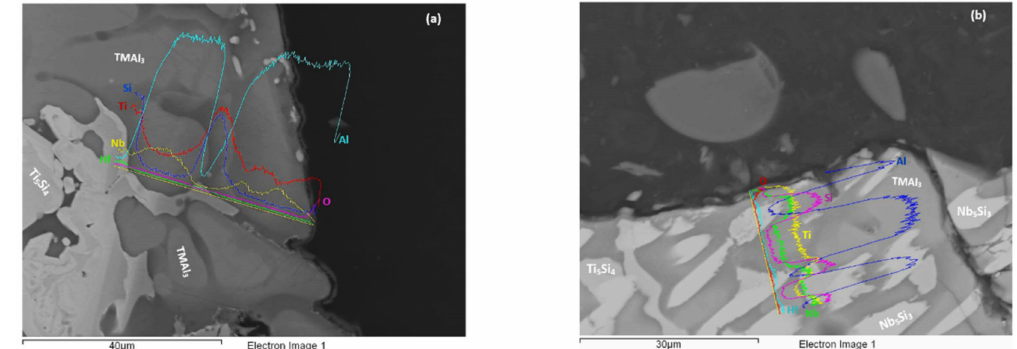
Figure 9. BSE images and EDS line scans from scale to bulk of oxidised specimens at 800 ◦ C of the alloys MG5 ( a ) and MG6 ( b ).